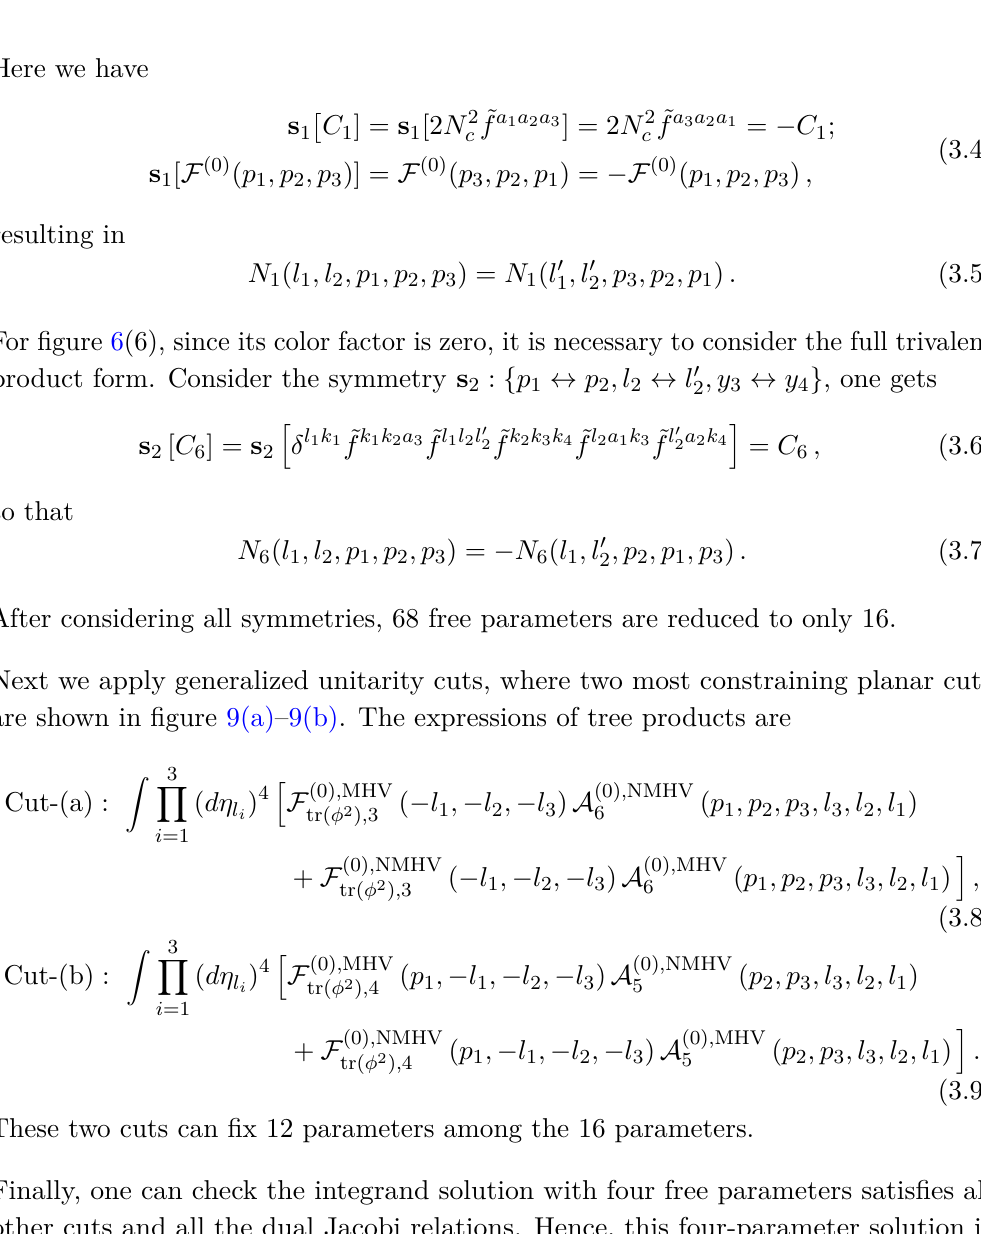
Figure 9. Triple cuts for two-loop three-point form